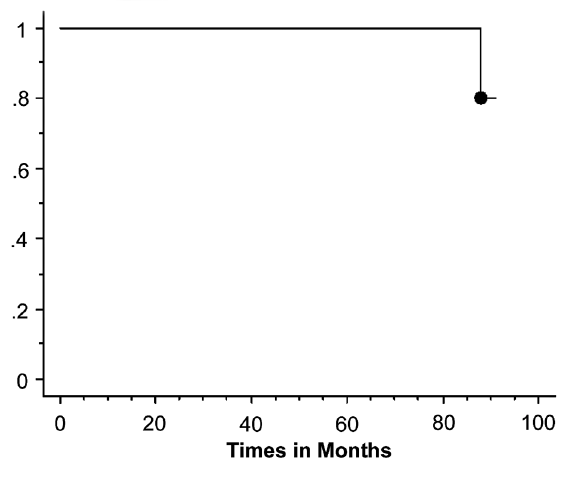
Figure 1 – Cancer-specific survival rate in patients undergoing nephron-sparing surgery by simple